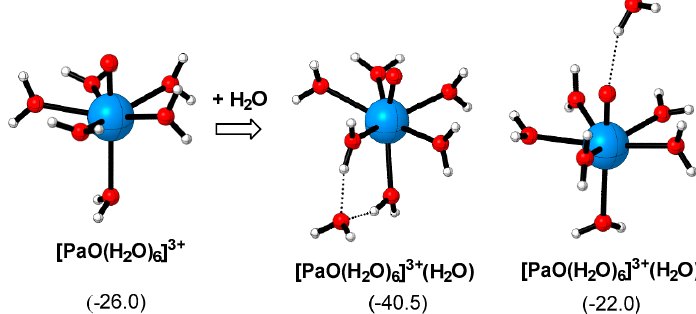
Figure 7. Optimized geometries and relative Gibbs free energies of [PaO(H 2 O) 6 ] 3+ , [PaO(H 2 O) 6 ] 3+ (H 2 O) and [PaO(H 2 O) 6 ] 3+ (H 2 O)’, the blue, red, and white balls denote Pa, O, and H atoms, respectively. The energies are gained with the B3LYP-D3(BJ)/GEN/IEF-PCM//B3LYP/GEN /IEF-PCM method (for details see Table 2 caption).